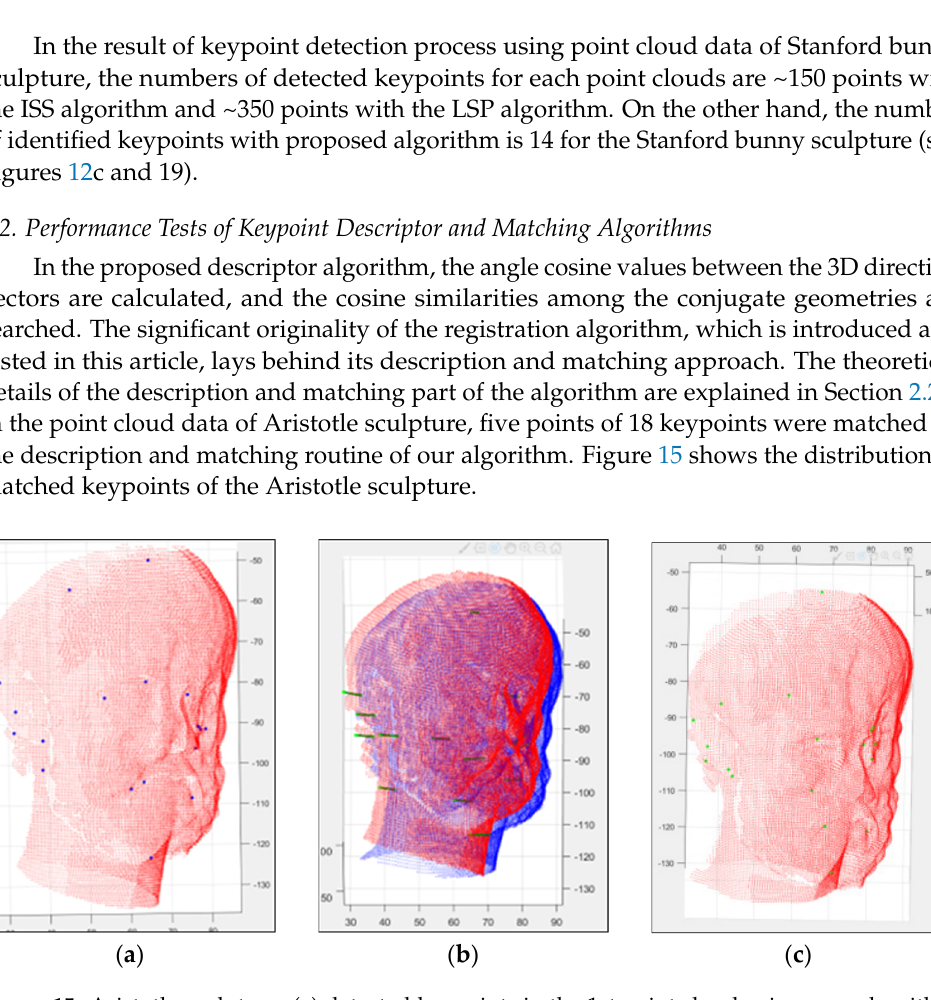
Figure 16. Aristotle sculpture: ( a ) the keypoints identified by ISS in the 1 st point cloud; ( b ) match- ing two-point clouds with the ISS+PFH algorithm; ( c ) the keypoints identified by ISS in the 2nd point cloud.